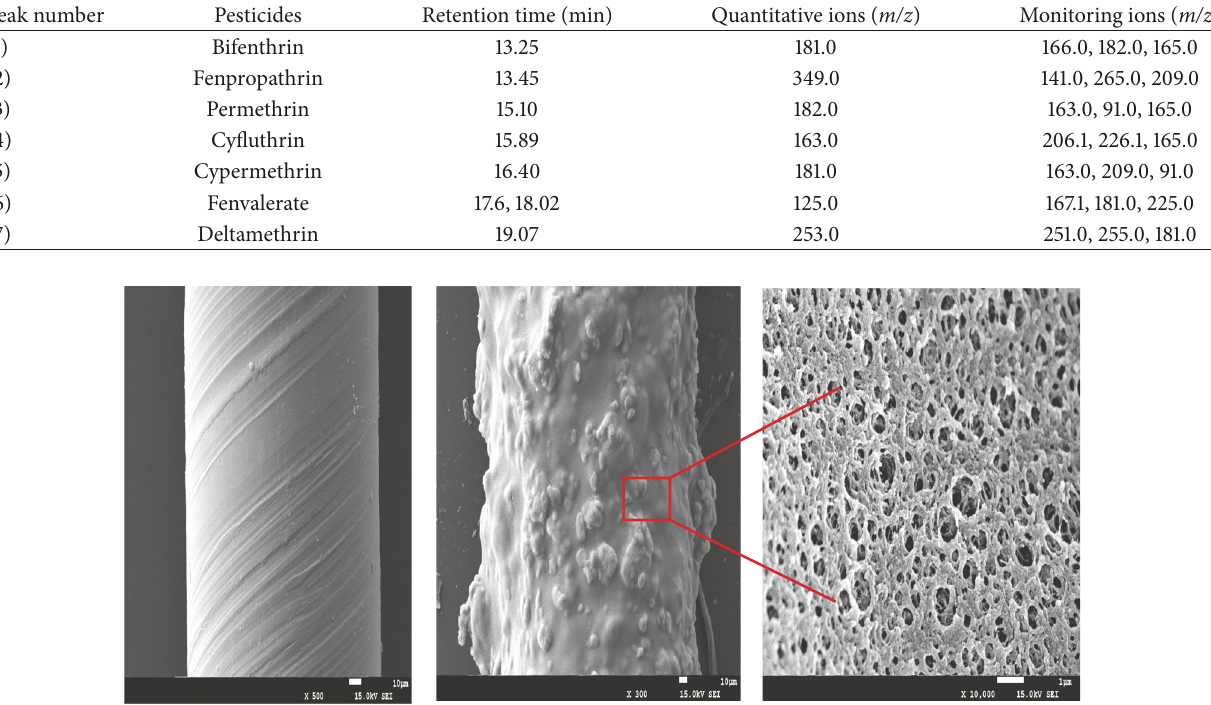
Figure 1: SEM images of the MWCNTs coated fiber, (a) the image of the stainless steel wire, (b) the image of the coated fiber’s surface, and (c) the image of the coated fiber’s inner